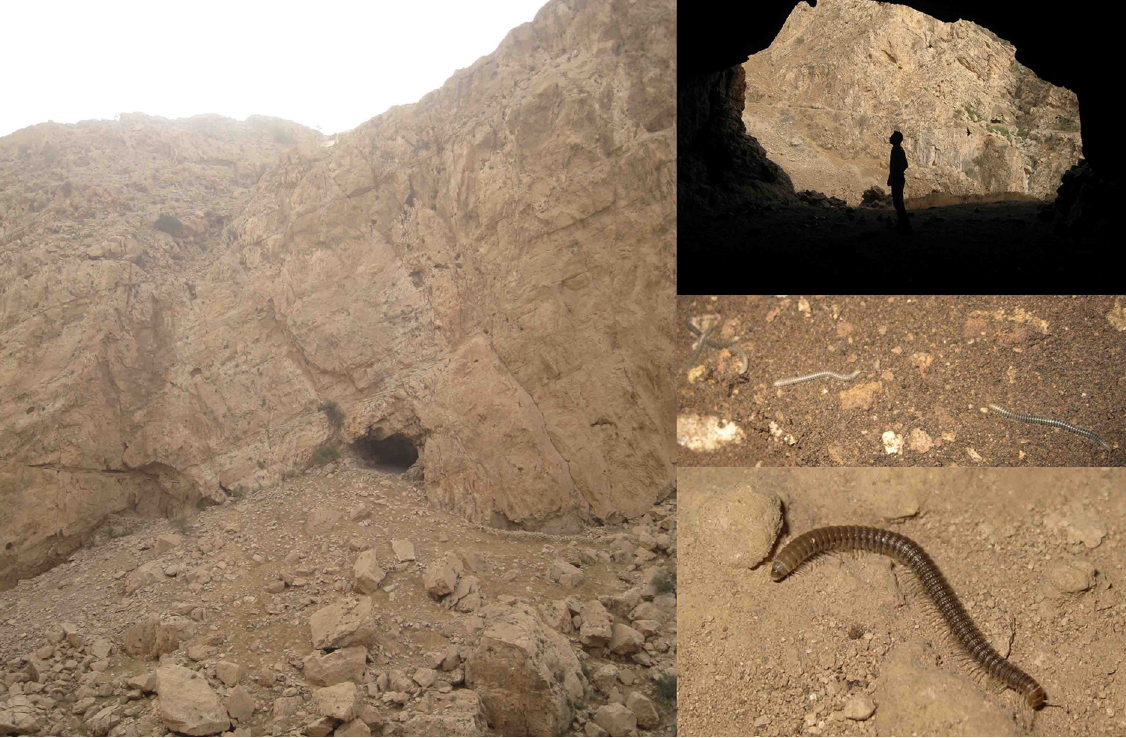
Fig. 10. Chiraziulus troglopersicus sp. nov., habitat; Neyneh Cave in Zagros Mountains,